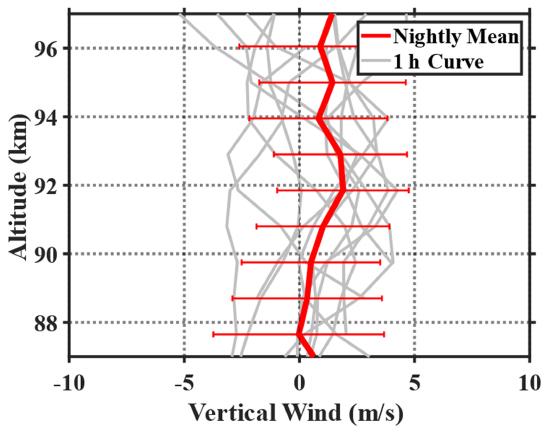
Figure 8. Vertical wind profiles of PMCW-NSL on 24 November 2021.